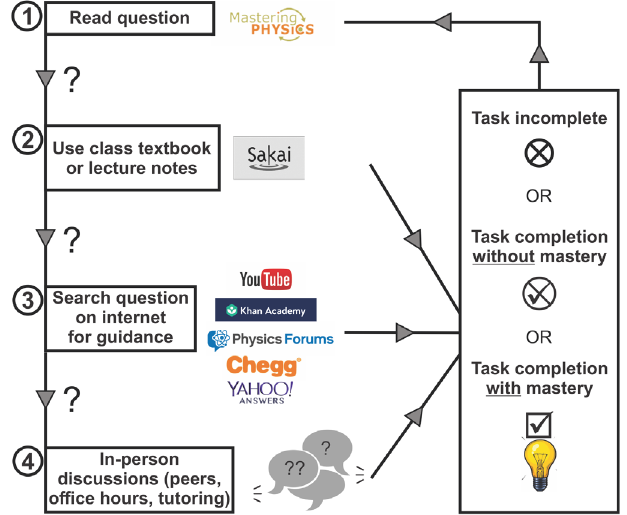
FIG. 13. Patterns of students ’ homework process for a given question, extracted from interviews ( N ¼ 11 ). Students (i) read the question, (ii) look to course materials for help, (iii) use online resources, and (iv) seek in-person help. Question marks represent students ’ persistent confusion which drove them to use the next resource. At any point in during Steps (ii) – (iv) students may choose to leave the task incomplete, seek solutions to finish the task without engaging in learning, or strive to learn while completing the task before moving on to the next question and repeating the